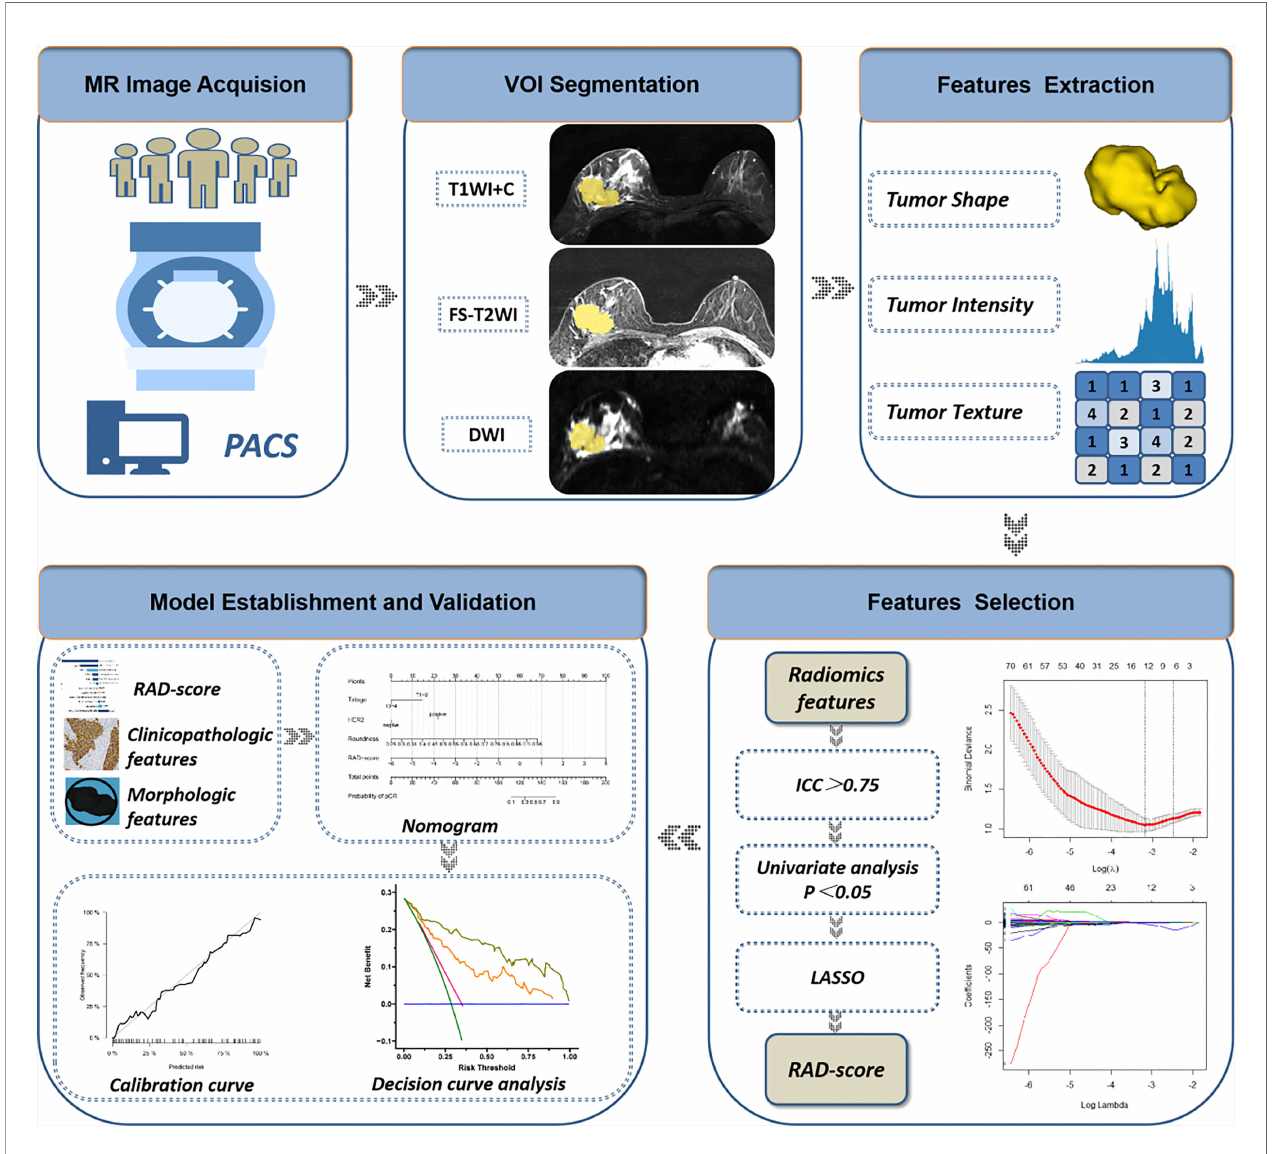
FIGURE 3 | Flowchart of extraction of radiomics features, model establishment and performance evaluation. ICC, intraclass correlation coef fi cient; LASSO, least absolute shrinkage and selection operator; RAD-score, radiomics